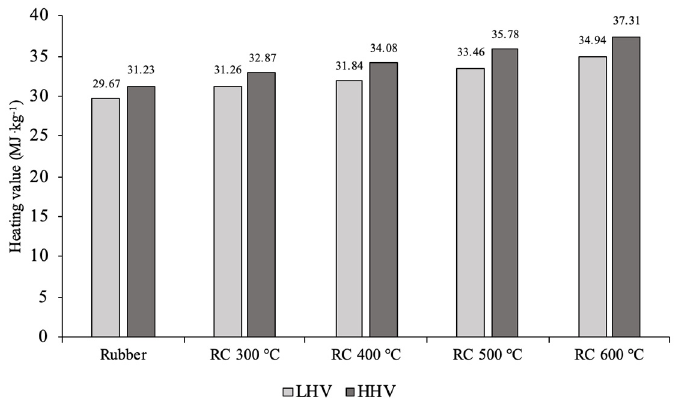
Figure 7. Low (LHV) and high (HHV) heating values of the analyzed samples.